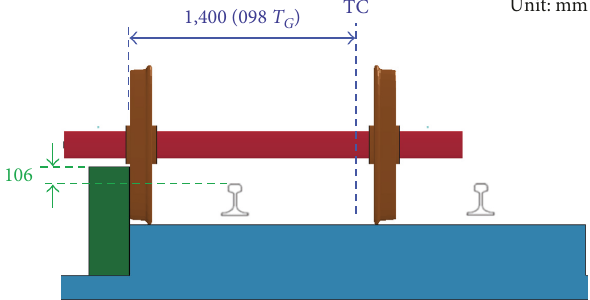
Figure 20: Overview of height effect 3.